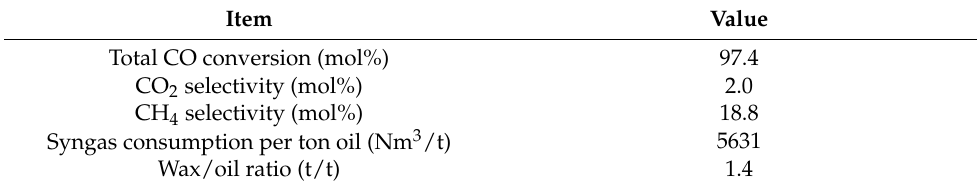
Figure 16. FTS products acquired at a million-ton FTS plant using the CNFT-1 catalyst. From left to right are the stable wax, heavy oil, light oil, and synthetic water, respectively. Table 13. Industrial application performance of